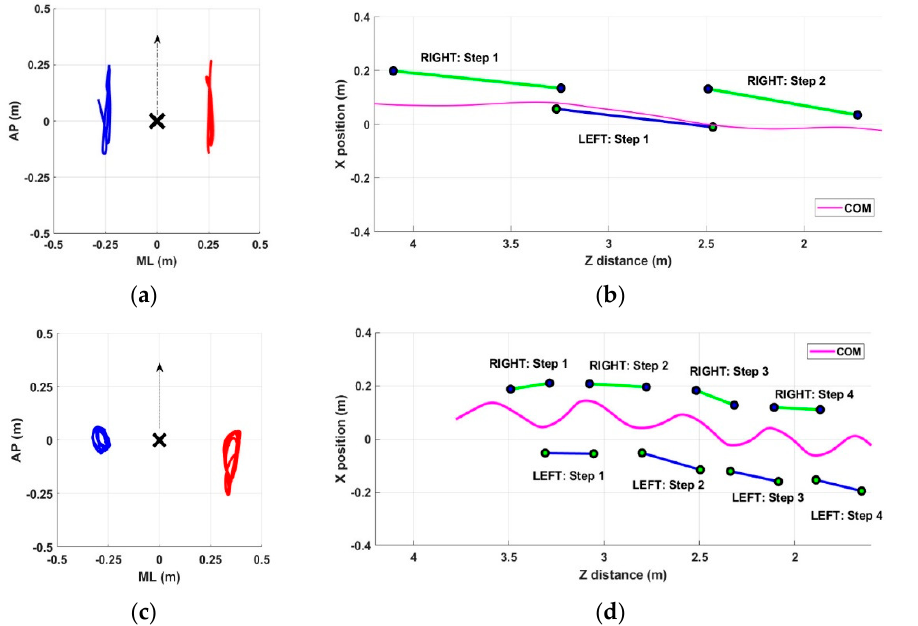
Figure 2. Example of arm swing trajectories (in meters) and gait patterns for PD subjects. ( a ) Subject #10: arm swing in AP and ML directions for left arm (red line) and right arm (blue line) relative to pelvis joint (black cross); ( b ) subject #10: gait patterns with detected steps and center-of-mass trajectory within the GAP zone; ( c ) subject #6: arm swing on AP and ML directions for left arm (red line) and right arm (blue line) relative to pelvis joint (black cross); ( d ) subject #6: gait patterns with detected steps and center-of-mass trajectory within the GAP zone.